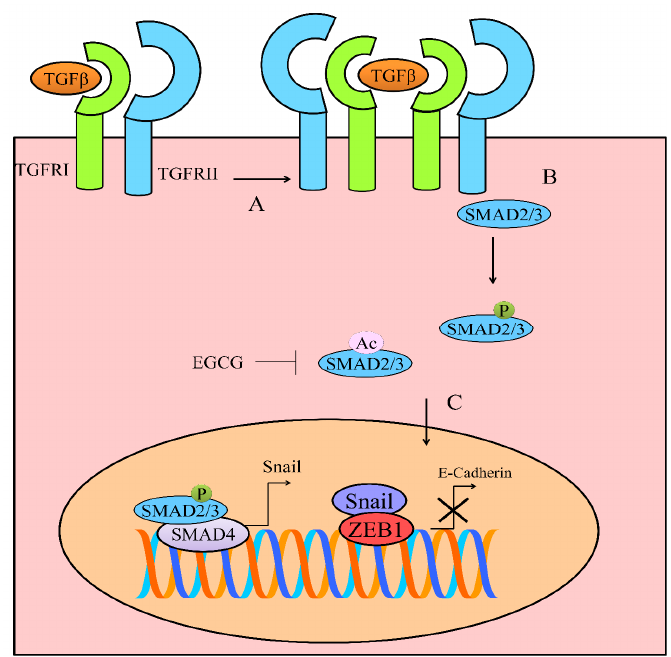
Figure 3. ( A , B ) Binding of TGFβ superfamily ligands to a type II receptor induced juxtapositioning of type I receptor. Phosphorylation of SMAD2/3 promoted its accumulation in the nucleus.